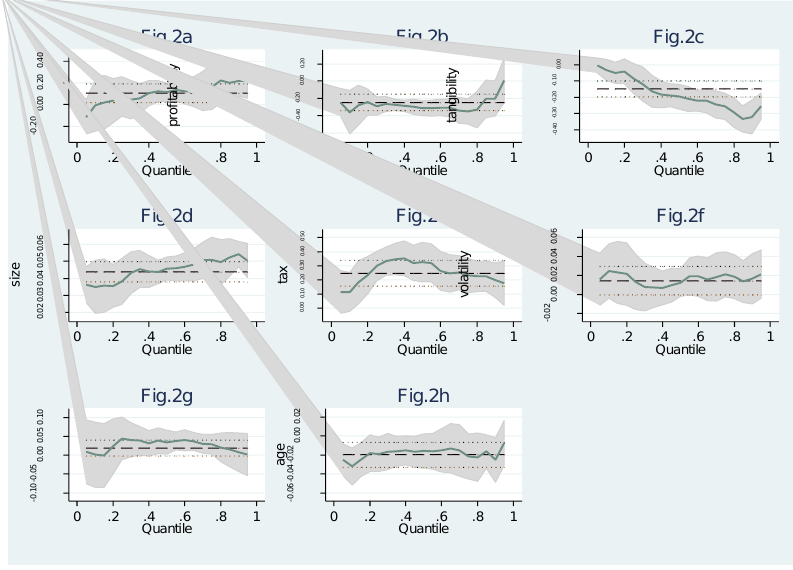
FIGURE 2: Plots of coefficients over quantiles for long-term debt ratio